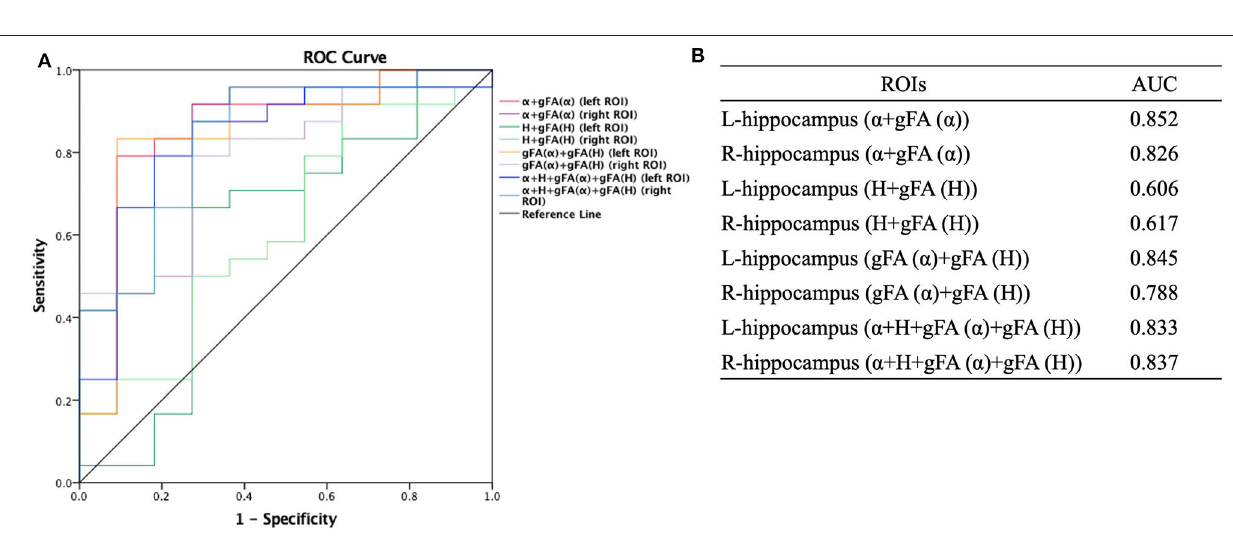
FIGURE 8 | Receiver-operating characteristic (ROC) curve was generated using the combination of gFA values and averaged values of α , H , and ADC for differentiating AD patients and healthy controls ( n = 24, n = 11, respectively). (A,B) The combinations { α , gFA( α )}, {gF( α ) + gFA( H )}, and { α , gFA( α ), H , gFA( H )} of the bilateral ROI perfectly separated AD patients and healthy controls. The α combination { α , gFA( α )} outperformed the directionally averaged α . ROC, receiver operating characteristic; ROI, region of interest; AUC, area under the curve; gFA, generalized fractional anisotropy; ADC, apparent diffusion coefficient; AD, Alzheimer’s